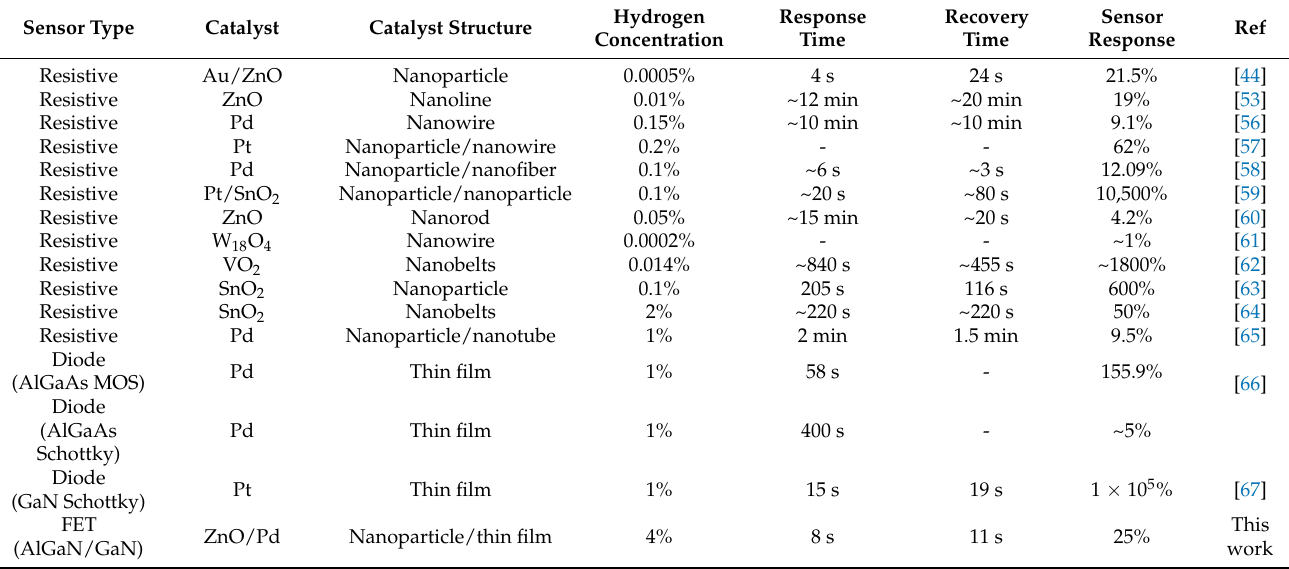
Table 1. Comparison of hydrogen sensor characteristics reported at room temperature.